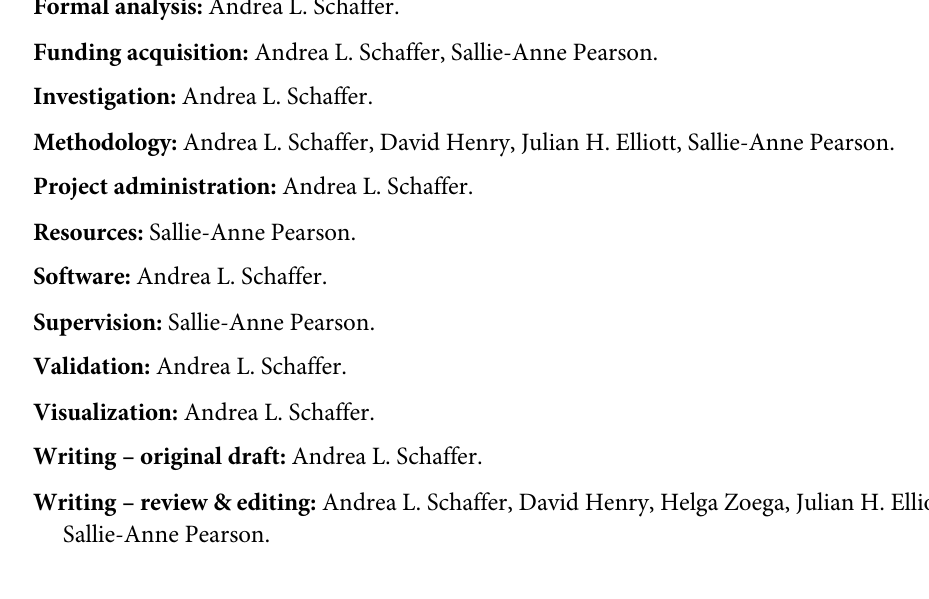
S4 Table. Monthly change in dispensing in 2020 compared with predicted values estimated using ARIMA models with 10% sample of PBS data where the dispensing date is offset by +/- 14